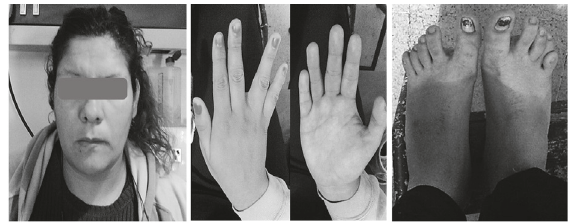
Figure 1: Physical examination: notefrontomalar prominencein the face. In the upper limbs there was cutaneous syndactyly of the lower third and bilateral fifth finger clinodactyly. In lower limbs there was separation of the first toe; brachydactyly of the 4th and 5th toes in the left foot and in the right foot 5th finger was overlapping over the